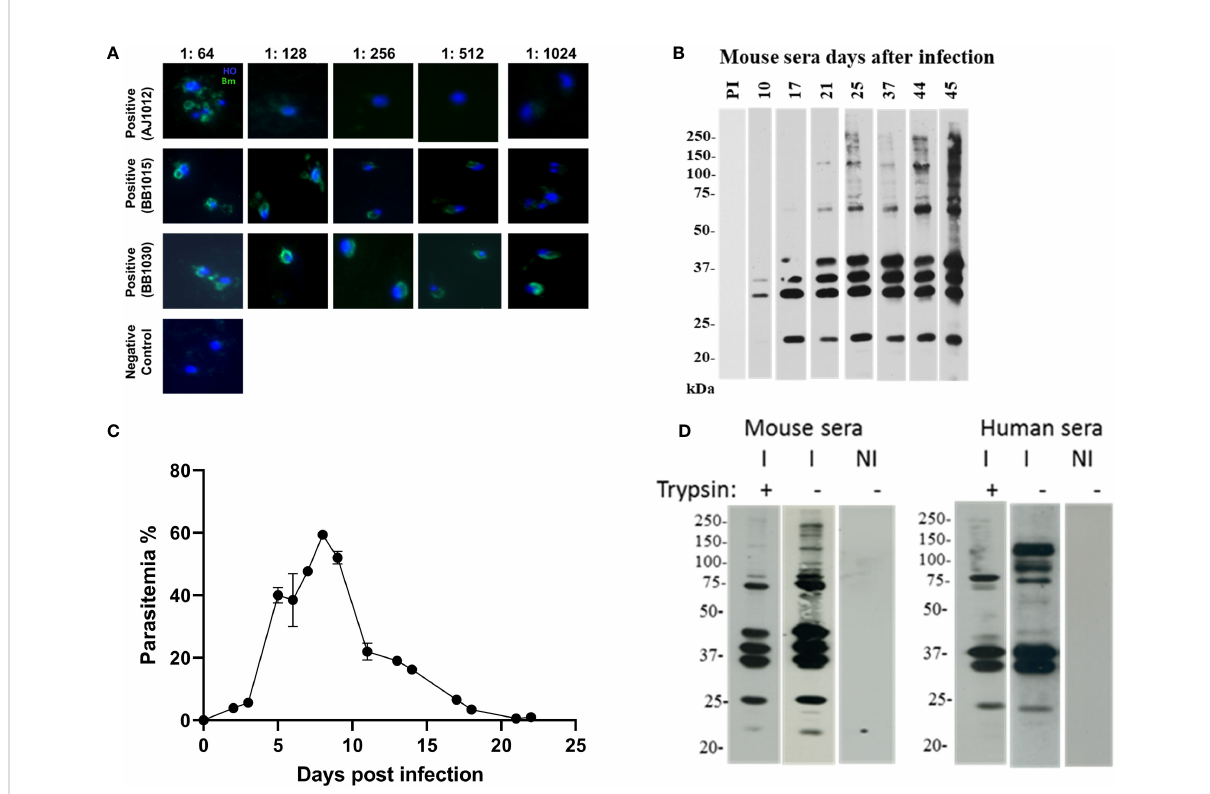
FIGURE 4 EV proteins are recognized by immune sera of B. microti – infected humans and mice. (a and b) Selection of sera and appropriate dilution to be used in extracellular vesicle (EV) immunoblots. (A) Sera were collected from human patient donors, and immuno fl uorescence was performed using B. microti – infected cells stained with Hoechst (blue). Anti-human secondary antibody (green) was used to detect immunopositive antigens. Three sera were used as labeled, and different sera titers were used. These sera were pooled and further used at 1:128 dilution. (B) Mice (n = 5) were infected with B. microti , and the reactivity of each mouse serum was monitored over days of infection. As shown, pre- immune (PI) sera did not react with B. microti lysate. At day 45, the maximum number of parasite antigens were recognized by the immune serum, and this was used for subsequent experiments. (C) Parasitemia pro fi le of B. microti – infected mice is shown until day 22 post invasion. As evident, parasitemia increases and peaks around day 7, after which it progressively falls as the parasite is cleared by the immune system. By day 20, parasitemia reaches almost zero, and no further increase is seen. (D) EVs puri fi ed from control uninfected and B. microti – infected mice plasma (same number of EVs were used in all lanes) were run on SDS-PAGE and probed with immune human or immune mouse sera from (A) and (B) , respectively. NI refers EVs puri fi ed from naïve mouse, and these did not react with either sera. As shown in the “ I − ” lanes, several antigens were recognized by the immune human and mouse sera. In lanes “ I+, ” EVs were subjected to trypsin before running on the SDS-PAGE and then probed using the human and mouse sera. Several bands disappeared on this treatment, suggesting the presence of these proteins on the surface of the